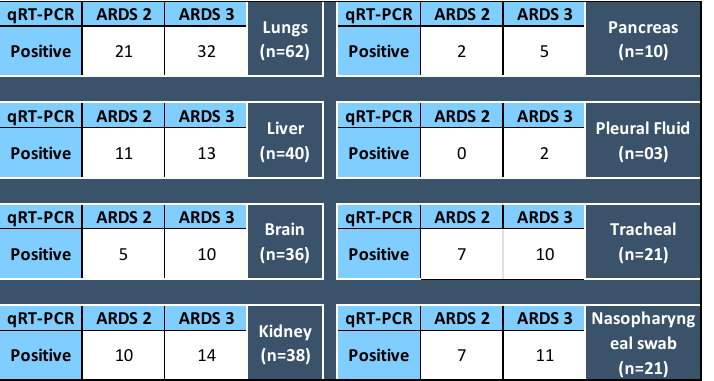
Figure 8. For each organ (total of samples tested for qRT-PCR), the number of positive detected in specimens collected from the autopsy of ARDS 2 and 3 category patients. p value for Fisher’s Exact Test > 0.05.